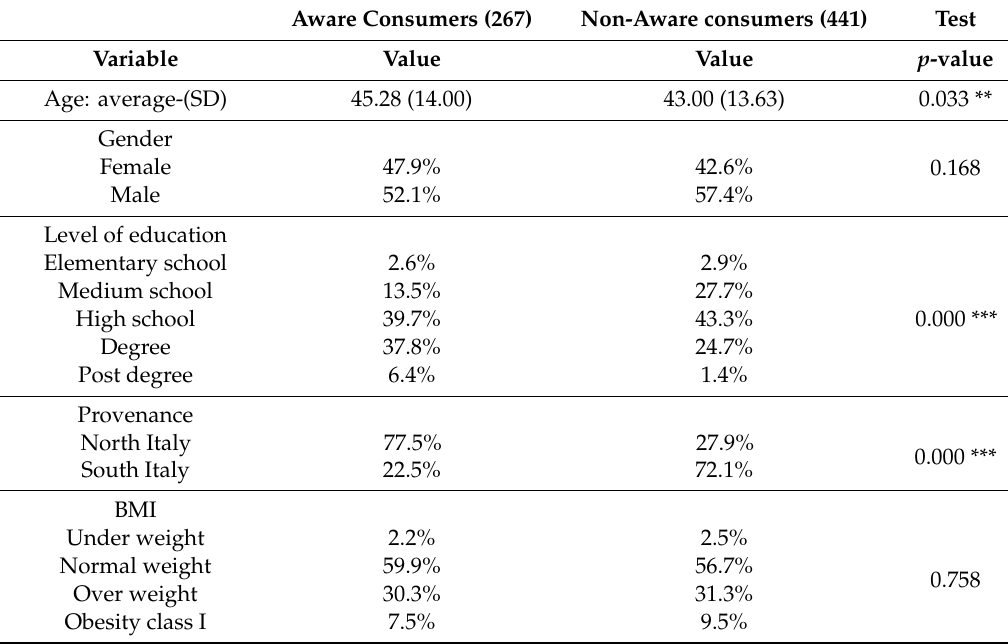
Table 3. Bivariate descriptive statistics for socio-demographic variables.